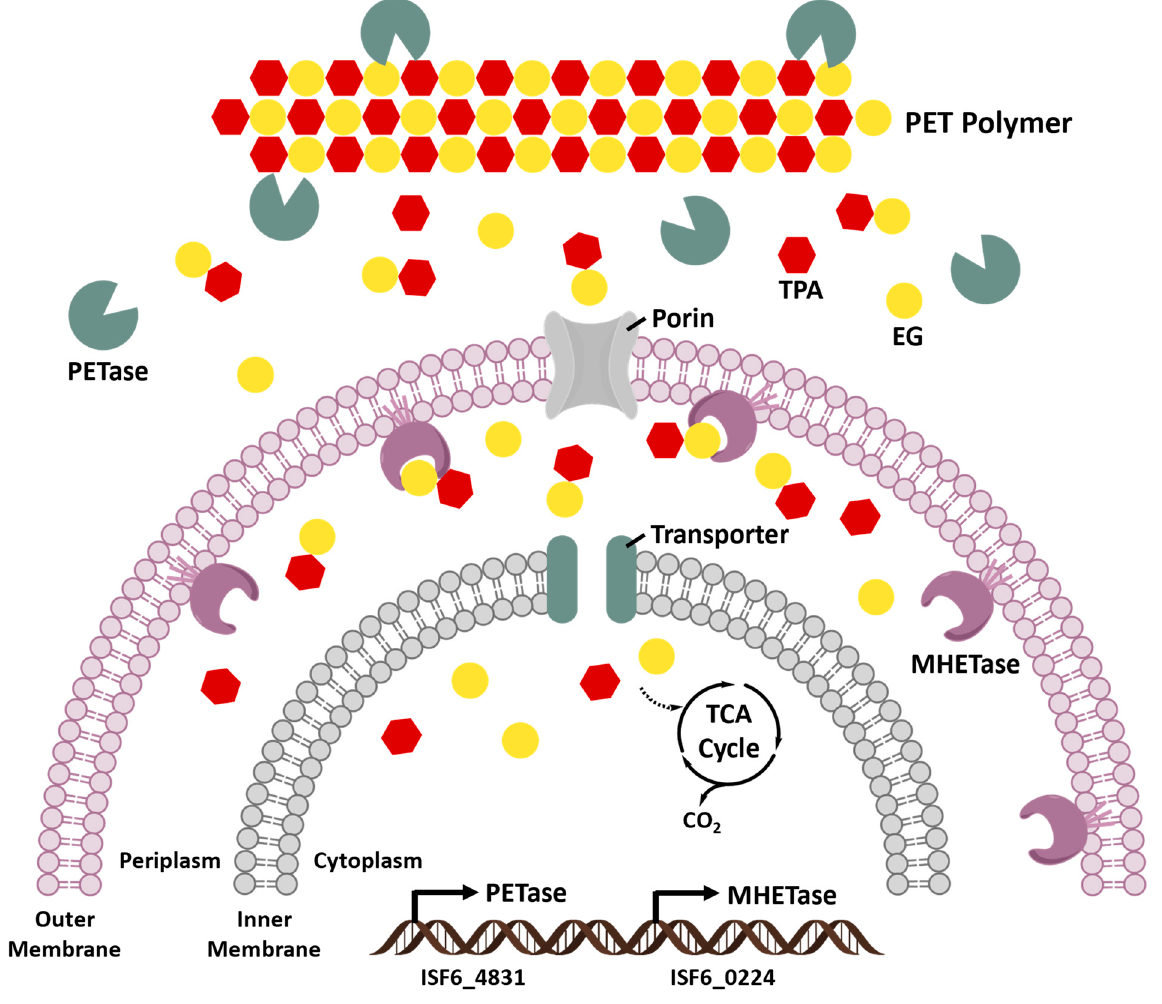
Figure 6. PET metabolic pathway by Ideonella sakaiensis [128].